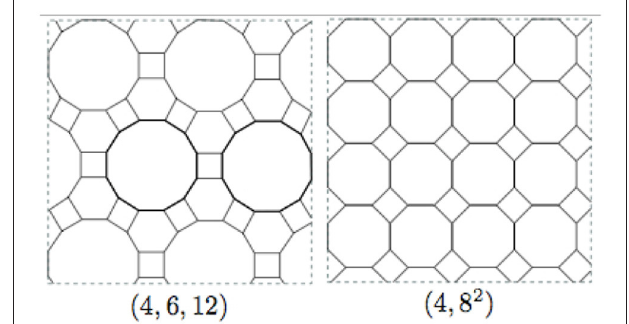
FIGURE 1 | Pictures of the (4,6,12) and (4,8 2 ) AL.